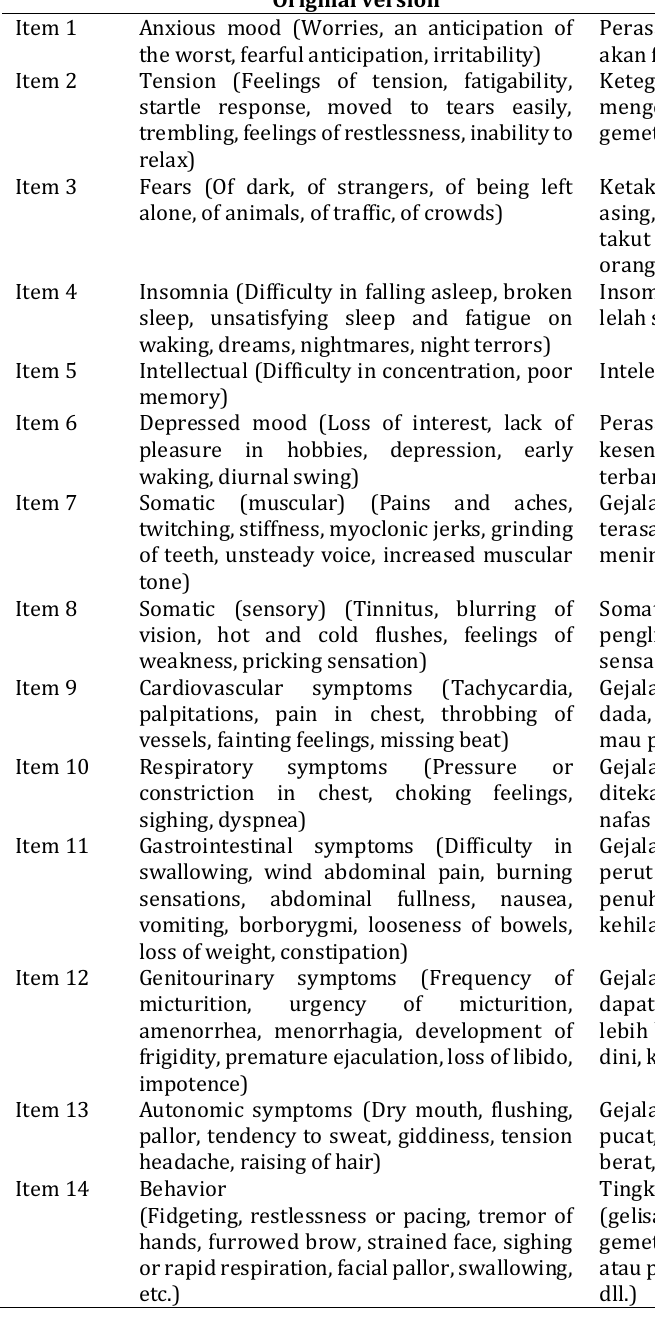
Table 2. The Hamilton Anxiety Rating Scale (HAM-A): Original (English)(Hamilton, 1959) and Translated (Indonesian)